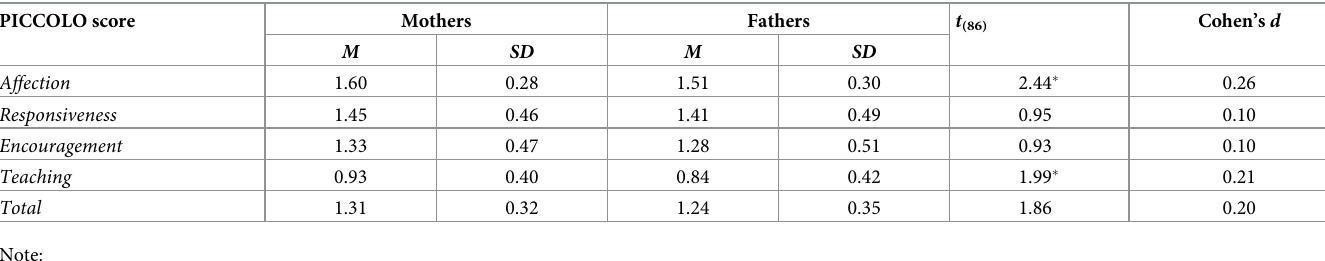
Table 2. Differences between mothers and fathers on PICCOLO domains and total scores (N = 87).